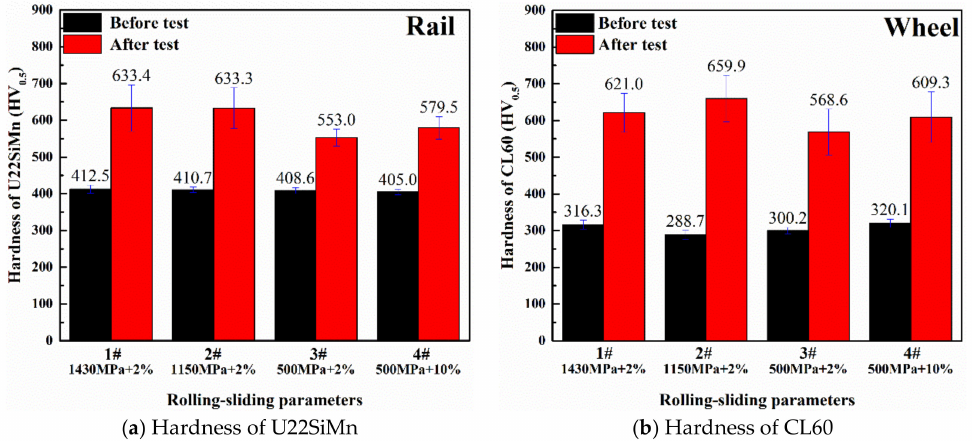
Figure 6. Surface hardness of rail and wheel